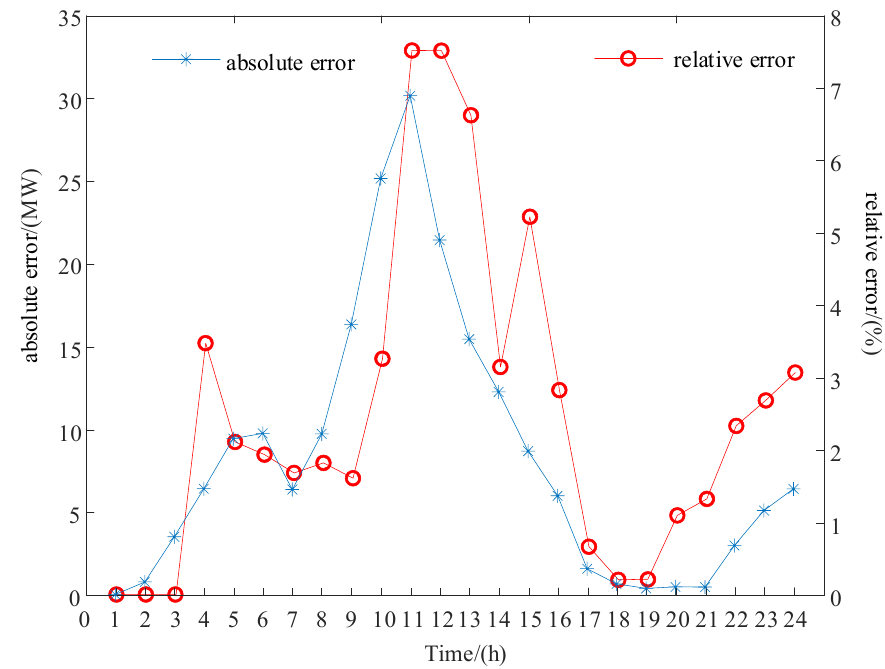
Figure 9. Comparison between relative error and absolute error.